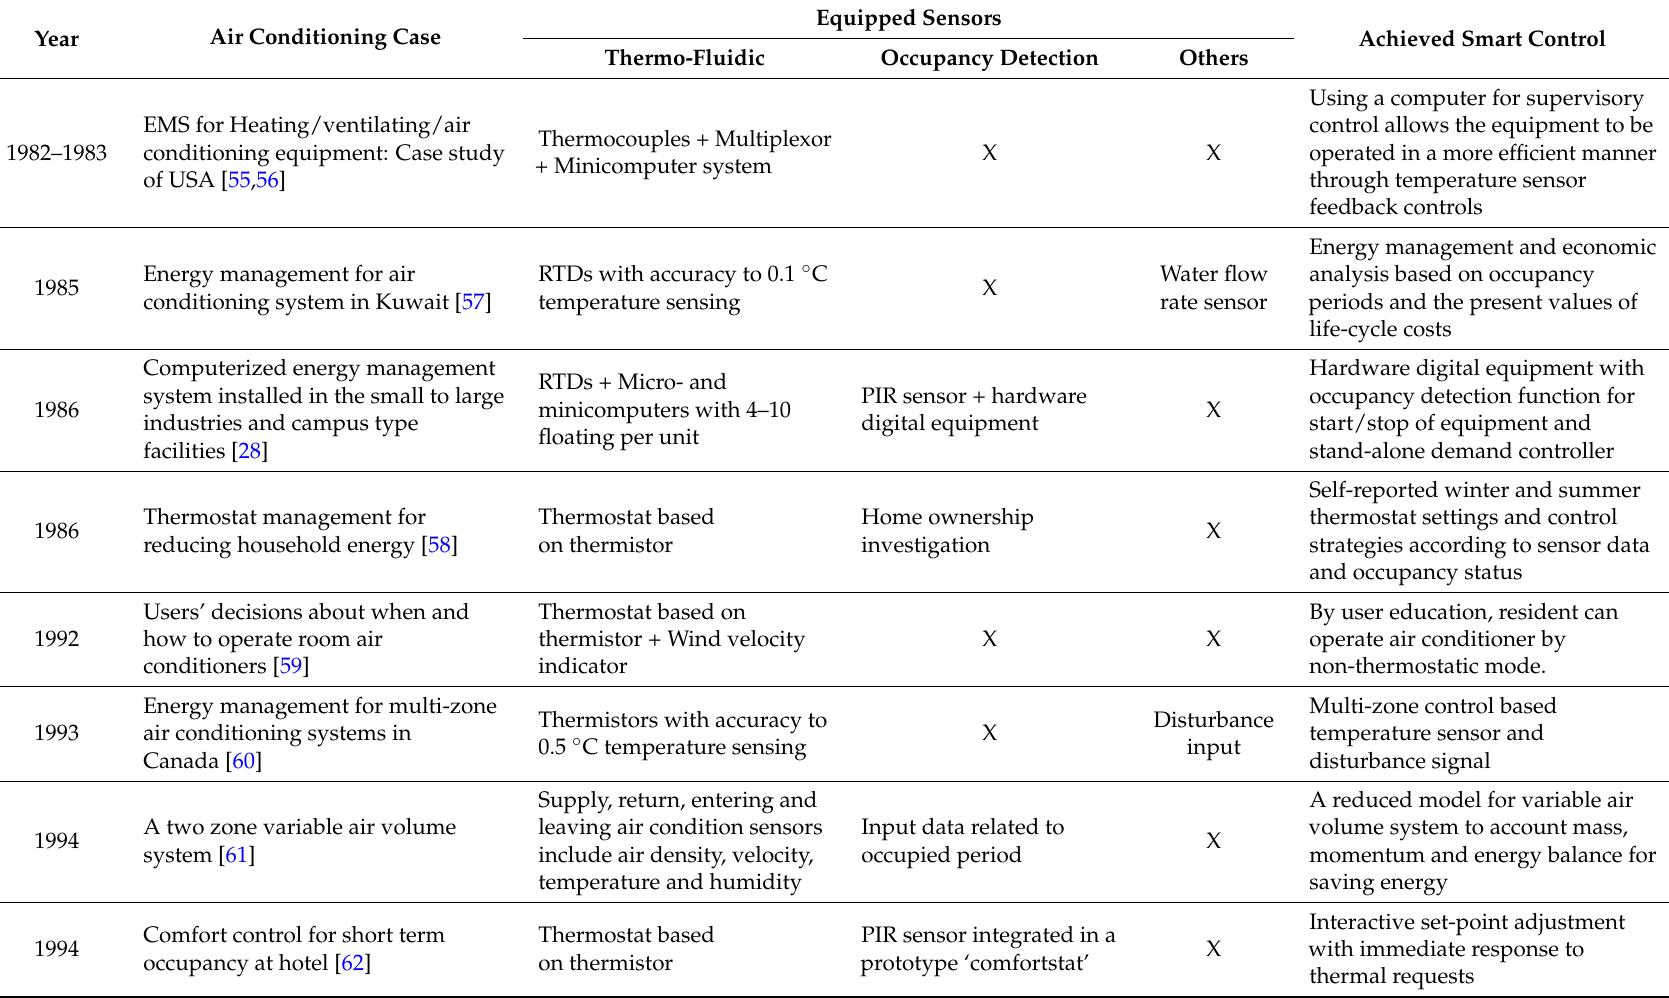
Table 2. Sensors employed by novel air conditioning system and achieved smart